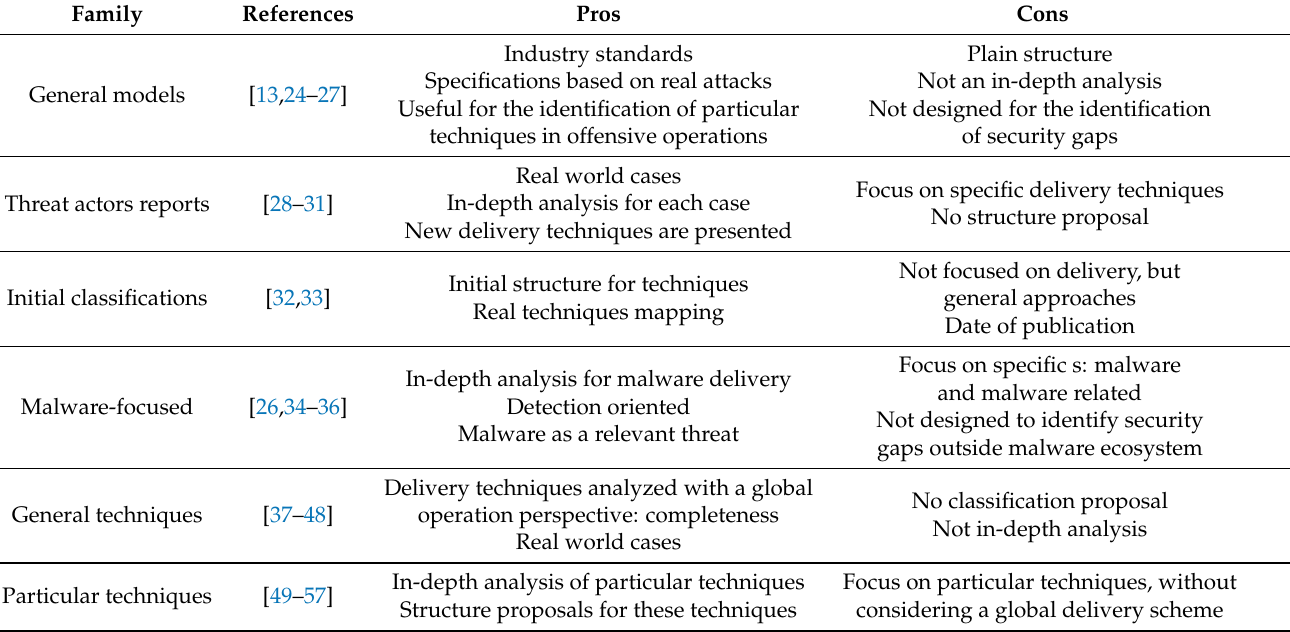
Table 1. Comparative literature